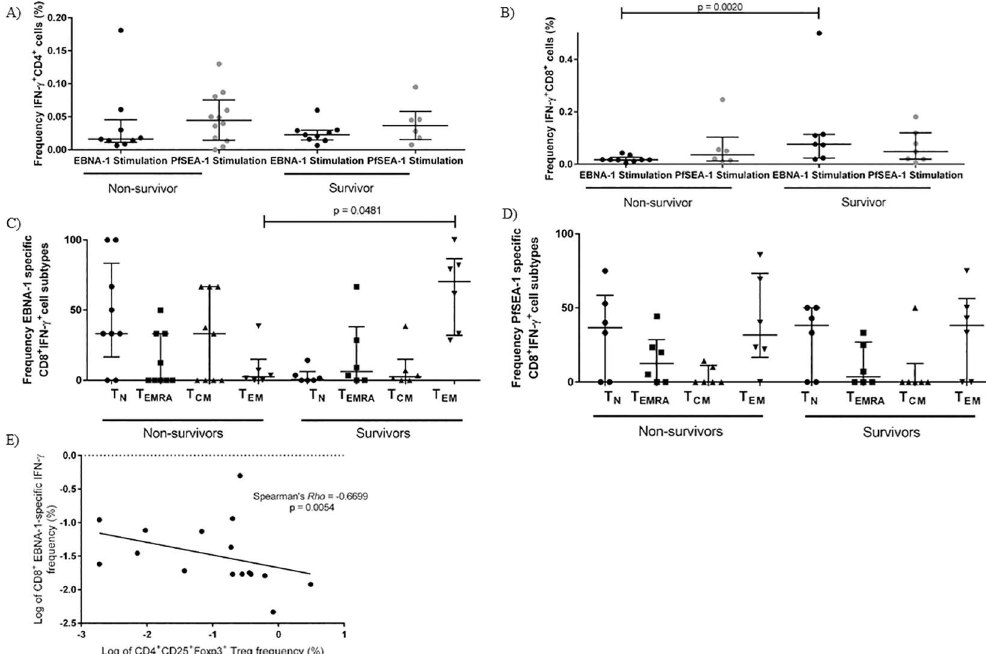
Fig 5. Non-survivors produce less EBV-specific IFN- γ , and from difference T cell subsets. Among IFN- γ producers, there was no difference in the magnitudeof CD4 + T cell IFN- γ production in response to EBNA-1 or PfSEA-1 stimulationbetweeneBL survivor and non survivors (A), non-survivors produced less CD8 + T cell IFN- γ from EBNA-1 stimulatedcells (B). Among EBNA-1-specific CD8 + T cell IFN- γ producers, survivors produced more CD8 + T cell IFN- γ from the CD45RA - CCR7 - effector memory (T EM ) cell subset than non-survivors (C). Among PfSEA-1-specific CD8 + T cell IFN- γ producers, there was no differencebetweensurvivorsand non-survivors in the cell type that producedIFN- γ (D). AmongIFN- γ T cell responders in both survivors and non-survivors, CD25 + Foxp3 + Treg frequencynegativelycorrelated with CD8 + T cell EBNA-1 IFN- γ production